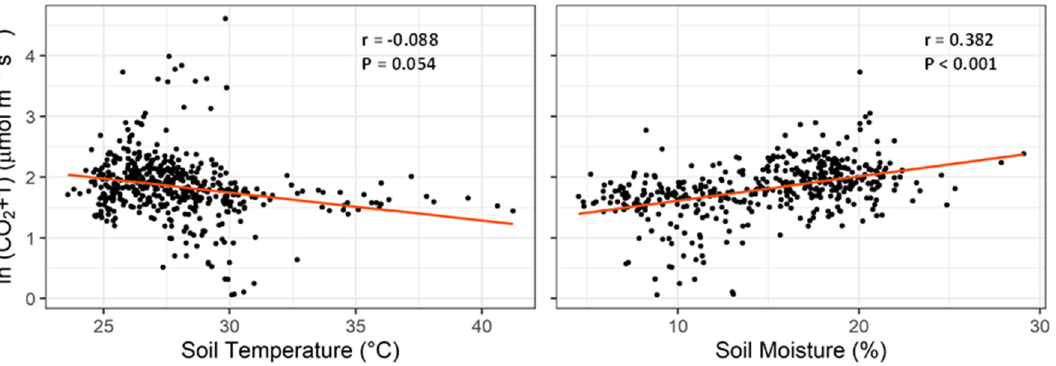
Figure 7. Correlations between CO 2 flux and soil temperature ( left ) and soil moisture ( right ).